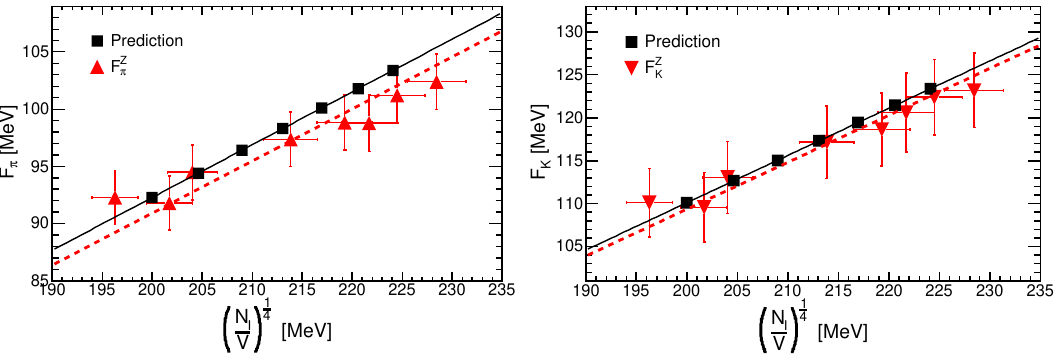
Figure 25 . Comparisons of the decay constants F (cid:25) (left) and F K (right) with the predictions. The black and red lines indicate the (cid:12)tting results of the predictions and numerical results,